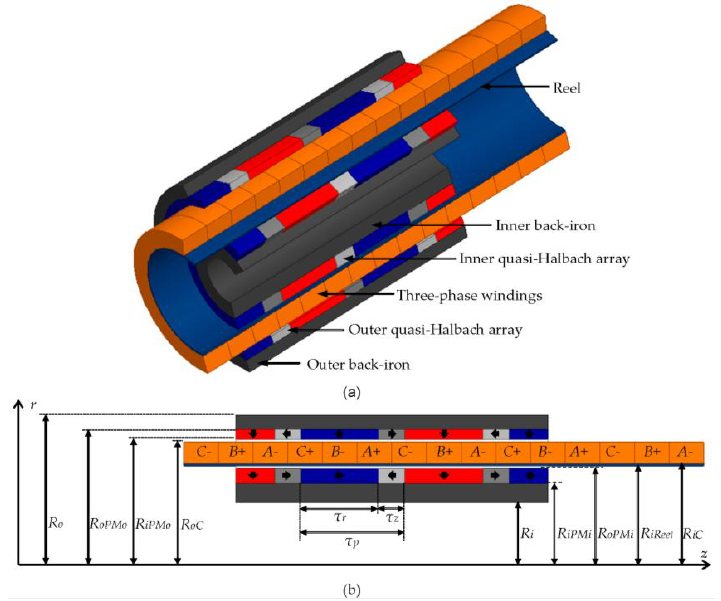
Figure 1. Linear tubular moving-coil actuator with a four pole dual quasi-Halbach array: ( a ) 3D isometric section view indicating structural elements; and ( b ) 2D half-section indicating design